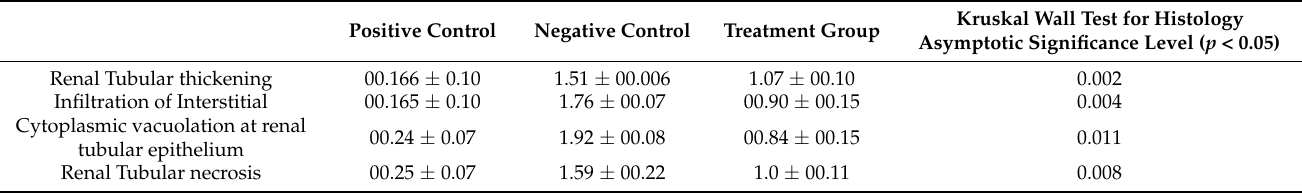
Table 4. Histological parameters of kidney in cigarette smoke and alloxan-induced diabetes are associated with renal